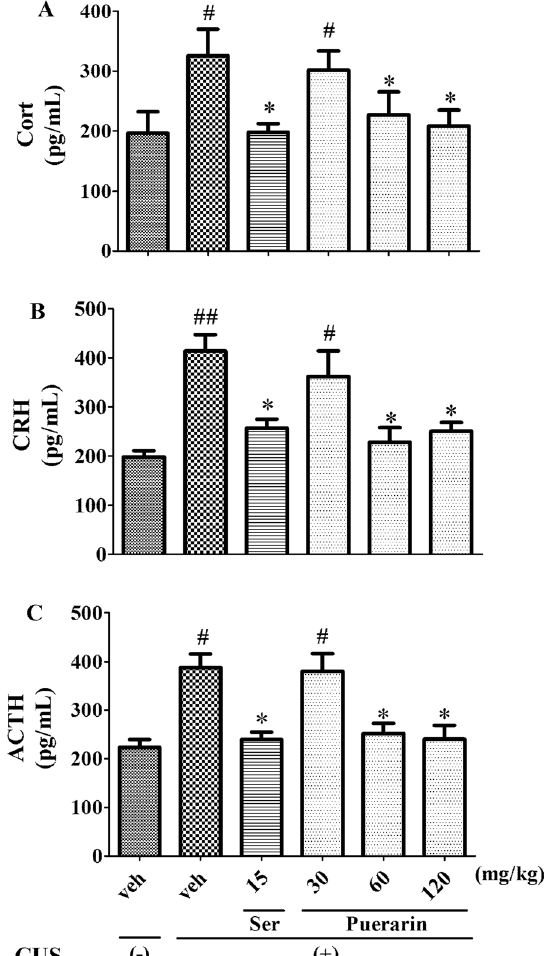
Figure 7. The effects of puerarin on Cort ( A ), CRH ( B ), ACTH ( C ) in serum. # p < 0.05, ## p < 0.01 vs. vehicle- treated CUS ( − ) group; * p < 0.05, ** p < 0.01 vs. vehicle-treated CUS ( + ) group (n = 6 per group).